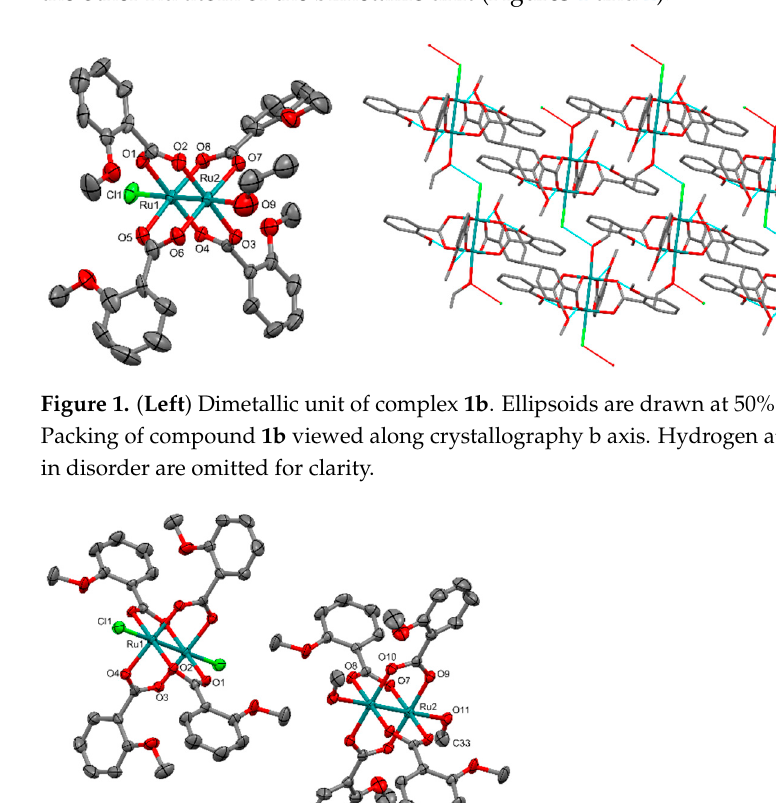
Figure 2. Bimetallic complexes of compound 1c . Ellipsoids are drawn at 50% probability level. Hydrogen atoms are omitted for clarity.